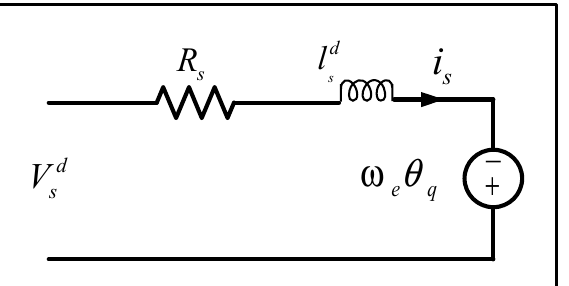
Figure 6. q axis PMSG mathematical model.